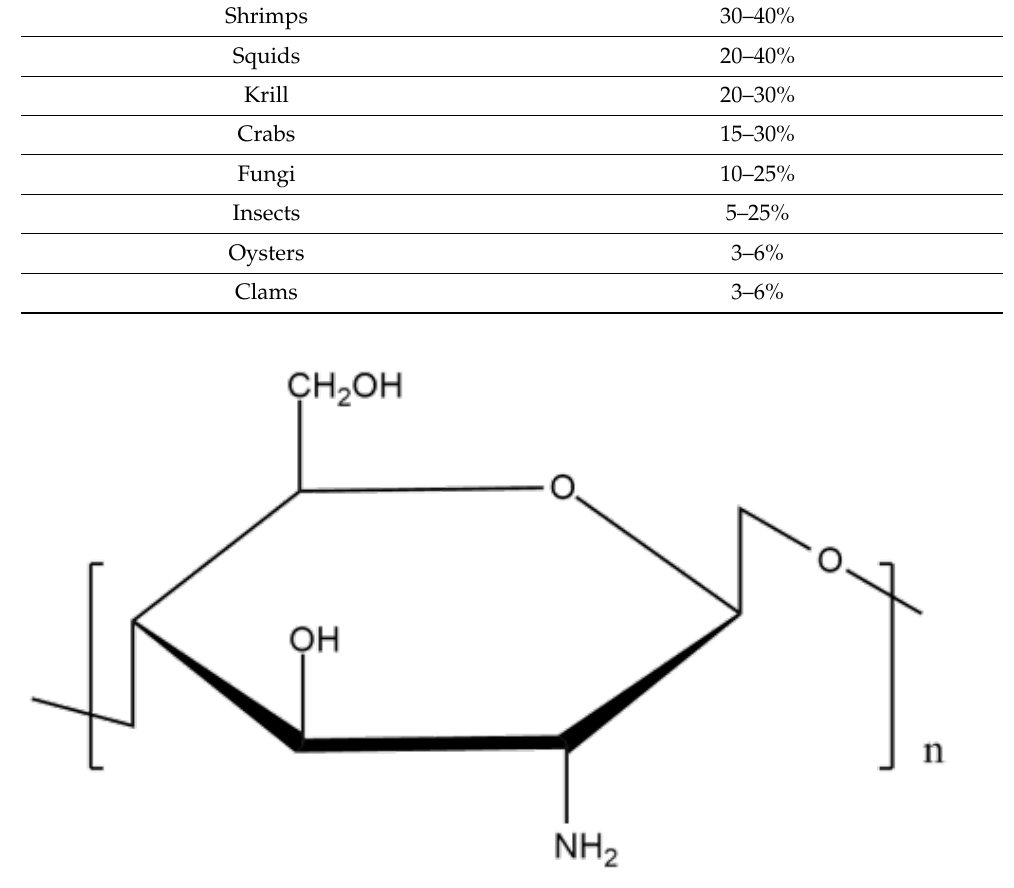
Figure 1. Chemical structure of chitosan.